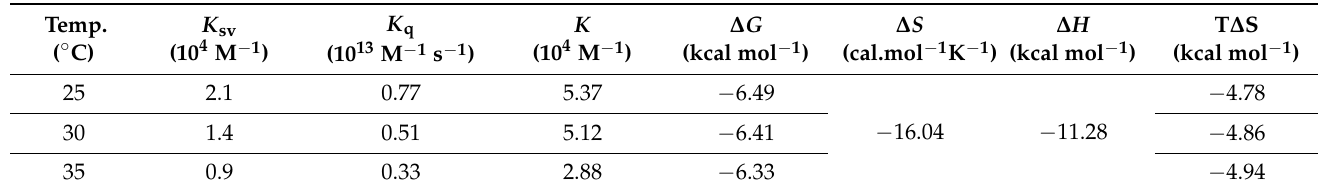
Table 1. Binding and thermodynamic parameters obtained for caffeic acid– α - amylase interaction obtained through fluorescence spectroscopy.